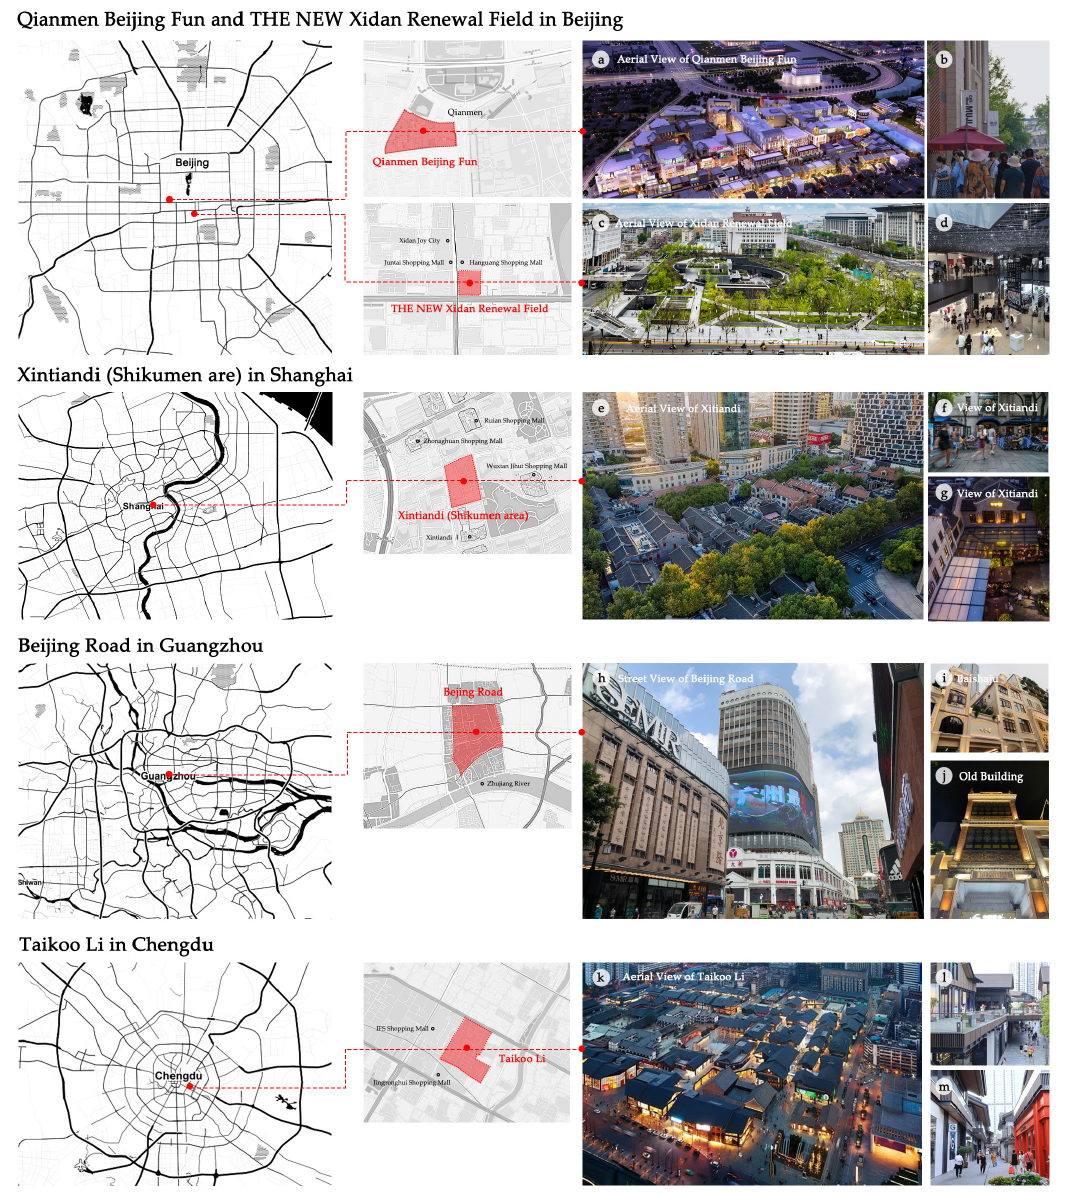
Figure 1. Location and features of the five urban renewal complexes [82–87]. ( b , d , l , m ) are photo- graphed by the author.